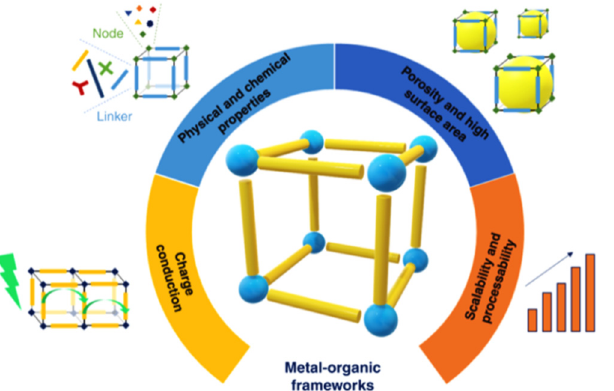
Figure 2. MOFs with tunable porosity, surface area, and charge conduction [4]. Reproduced with permission.